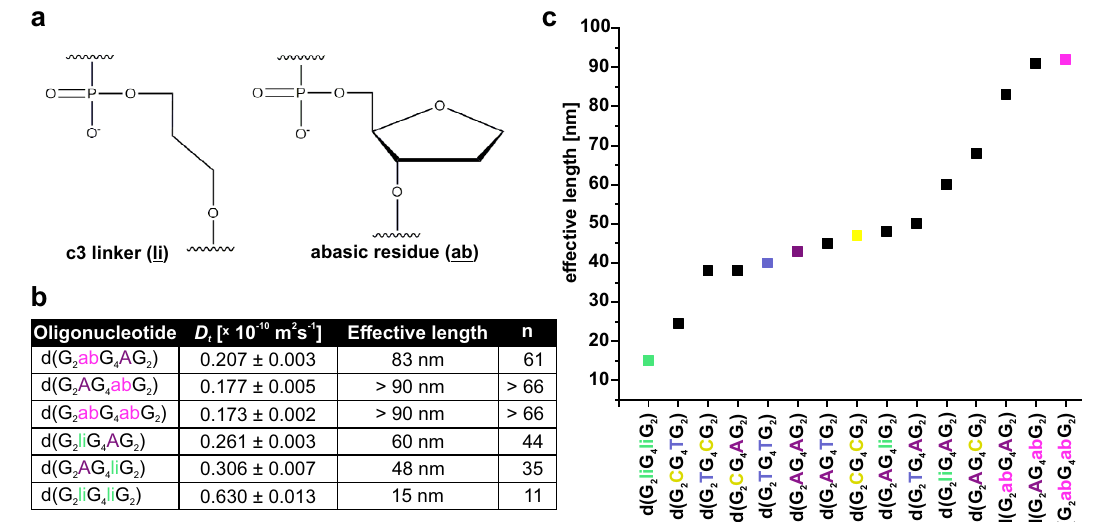
Fig. 5 C3 linker and abasic nucleotide in loops in fl uence the length of G-wires even more. a Chemical structures of c3 linker (li) and abasic residue (ab). b A table showing D t obtained from DLS measurements and calculated effective lengths and number of stacked Qt-type building blocks. c In plot, oligonucleotides are arranged by increasing effective length of resulting G-wires (from left to right). For visualization in plot we used 92 and 91 nm as effective lengths of the longest two G-wires d(G 2 abG 4 abG 2 ) and d(G 2 AG 4 abG 2 ), whose lengths exceed the validity region of the used model. Samples were assembled via method 1 (see “ Methods ” section).